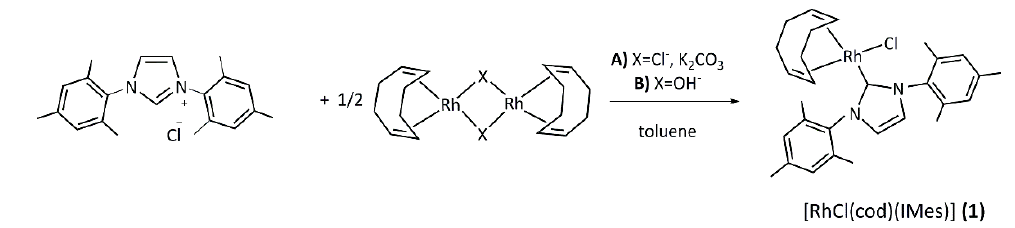
Figure 1. The Rh(I)-NHC complexes 1 – 4 used in our study as catalysts for selective nitrile